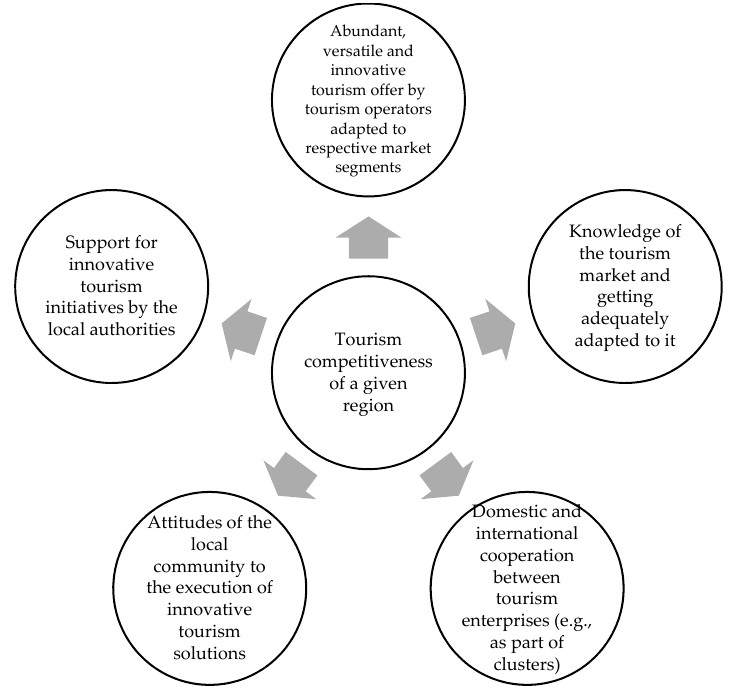
Figure 3. Factors enhancing the tourism competitiveness of the region under study. Source: [59–63].